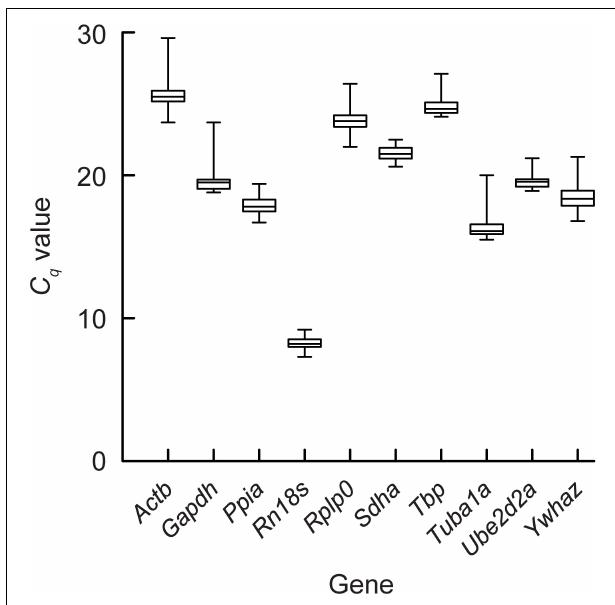
FIGURE 2 | Gene expression levels of the bank vole genes. The box plot represents the interquartile range, the median and the maximum and minimum quantification cycle ( C q ) values of for each